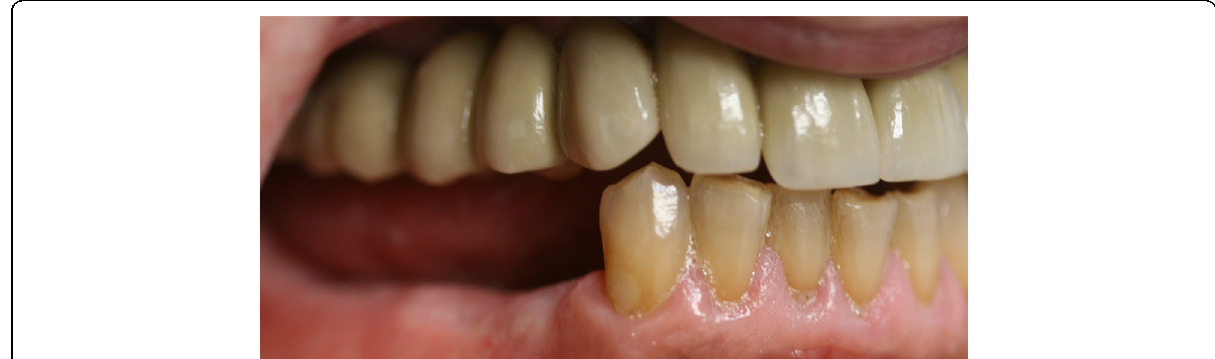
Fig. 6 Post-operative lateral view of the right maxillary